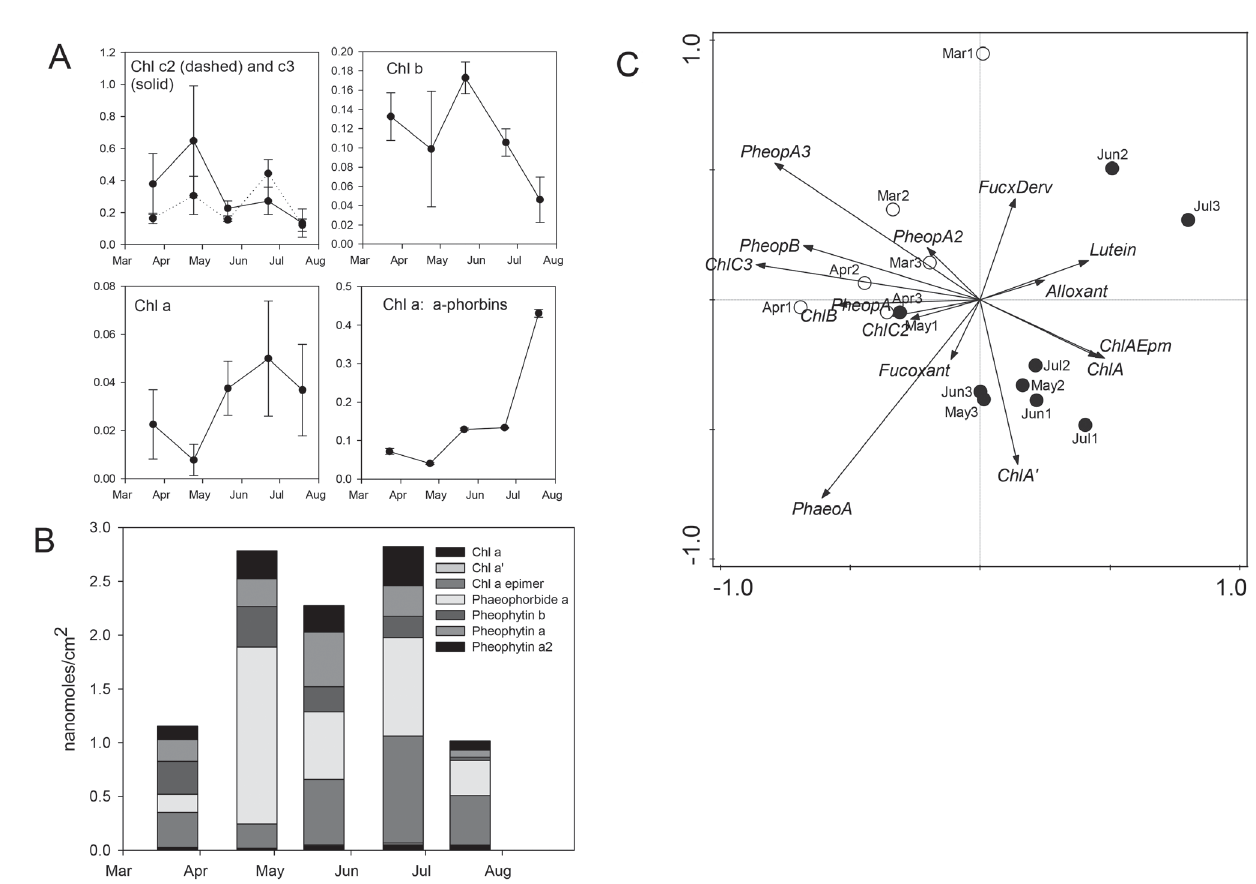
Figure 7 – Pigment measurements of artificial glass substrate biofilms: A, changes in mean pigment concentrations (± standard deviations); B, changes in concentrations of a-phorbins; C, PCA of algal pigments with replicates 1, 3 and 5 from dry season (March–April; open circles) and wet season (May–July; closed circles). Eigenvalues are λ